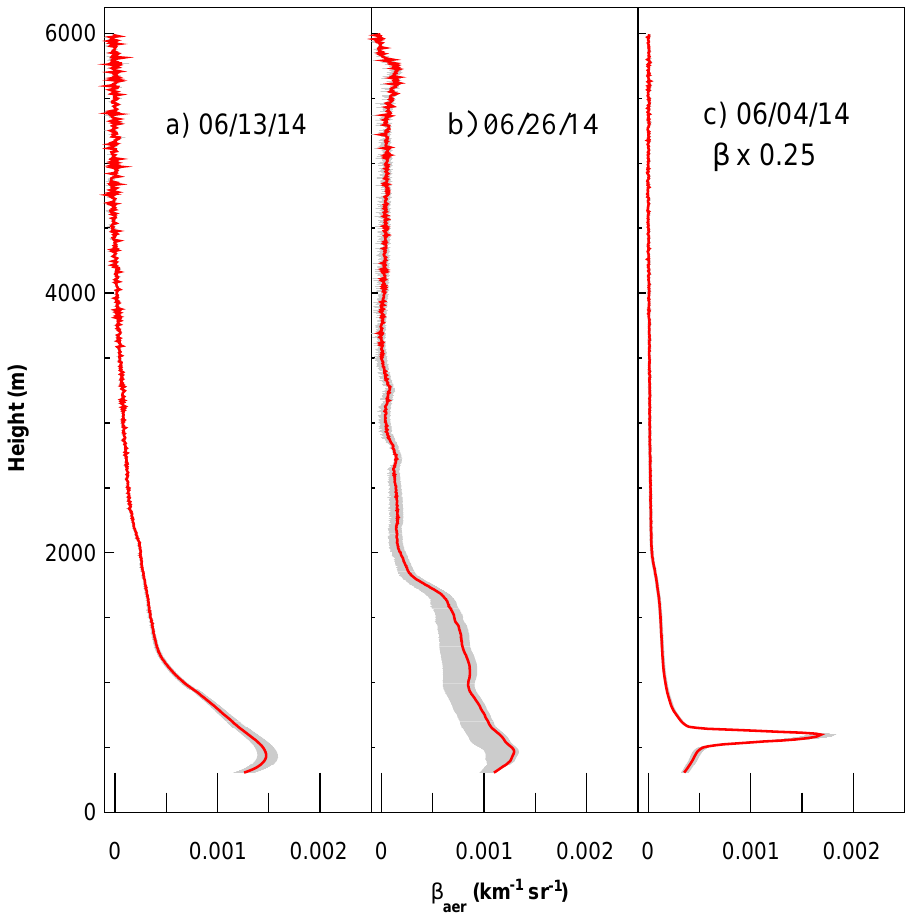
Figure 8. Daily average aerosol backscatter profiles for three representative measurement